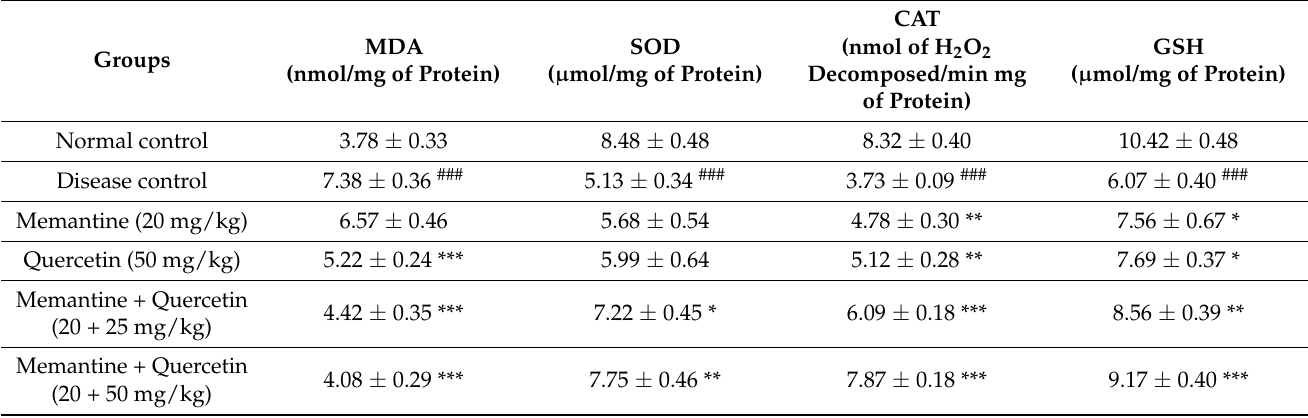
Table 1. Effect of quercetin and quercetin with memantine treatment on oxidative stress parameters in the